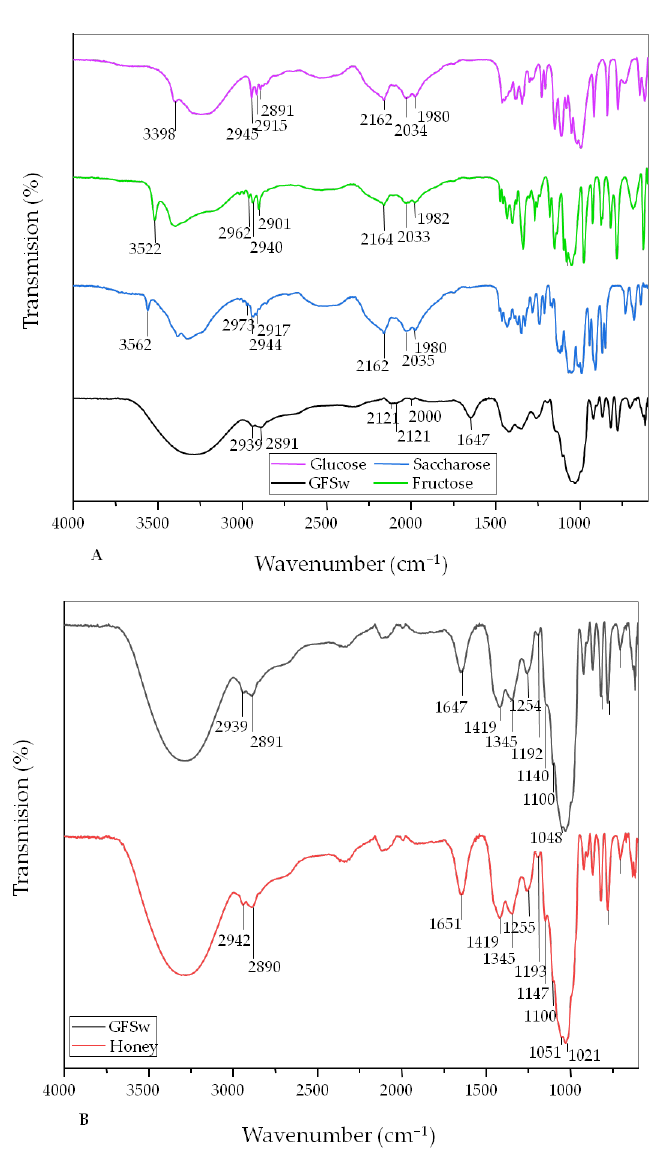
Figure 4. Comparison between the ATR-FTIR spectra of honey and the main components of GFSw — glucose, fructose, and sucrose ( A ) and between the ATR-FTIR spectra of honey and GFSw NaDES ( B ). The absorption bands from 1419 cm − 1 and 1345 cm − 1 are characteristic of the bending vibrations of O-CH and C- CH in the structure of carbohydrates or of the bending vibrations coming from OH from the C-OH group. The bands from about 1255 – 1140 cm − 1 are characteristic of the stretching vibration of C-H or C-O from carbohydrates. The vibration with a maximum of about 1100 cm − 1 is a band that can come from the C-O vibration in the C-O-C group. The bands of approximately 1055, 1025, 990, and 777 cm − 1 can be assigned to C-O stretching from the C-OH group or C-C from the carbohydrate structure. The band at 987–988 cm − 1 is characteristic of the glycosidic bond C-O-C. The spectral area from 898 to 818 cm − 1 is characteristic of the anomeric vibrational region of carbohydrates or the C-H deformation group